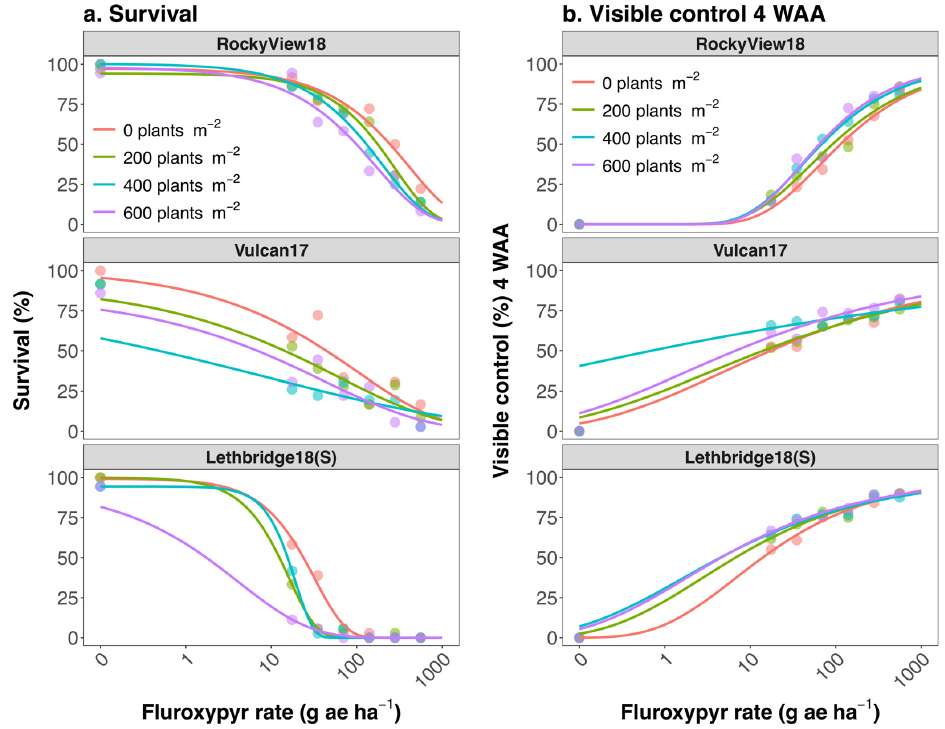
Figure 1. Plant survival ( a ) and visible control four weeks after application (WAA) ( b ) for three kochia populations [RockyView18, Vulcan17, and Lethbridge18(S)] in response to fluroxypyr rate and wheat plant density (0, 200, 400, and 600 plants m − 2 ). Kochia populations are displayed separately within each subfigure. Dots indicate means, while lines indicate the predicted values from the fitted three-parameter, and two-parameter Weibull type 1 models, respectively.